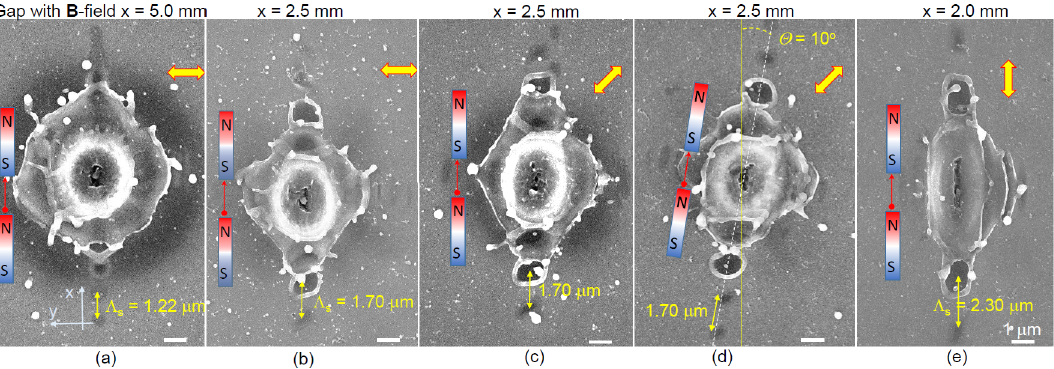
Figure 1. ( a ) 3D printed jig with a sample compartment gap of x = 2.5 mm surrounded by Nd-magnets (four on each side to maximise B-field strength ∼ 0.1–0.2 T, depending on separation x ). A ( 100 ) orientation silicon wafer was diced along the (110) plane to the required width; the magnetic field was oriented along (cid:104) ¯110 (cid:105) direction (perpendicular to the wafer base cut (cid:104) 110 (cid:105) ). The inset shows a Gaussian beam profile of the femtosecond laser used. ( b ) Scanning electron microscopy (SEM) images of single-pulse ablated regions with and without a magnetic field present. Laser pulses of λ = 1030 nm wavelength and t p = 230 fs pulse duration were focused with an objective lens of numerical aperture NA = 0.7 to a focal spot of 2 r = 1.22 λ / NA = 1.8 µ m diameter (comparable to the cross section at 1/ e 2 of a Gaussian beam). Pulse energy was E p = 1.13 µ J at the entrance of the objective lens (transmission of the lens was T = 0.22); fluence F p ≡ E p / A p = 9.8 J/cm 2 ; irradiance I p ≡ F p / t p = 42.7 TW/cm 2 with area A p = π r 2 . For the tilted-SEM view see Figure A1.